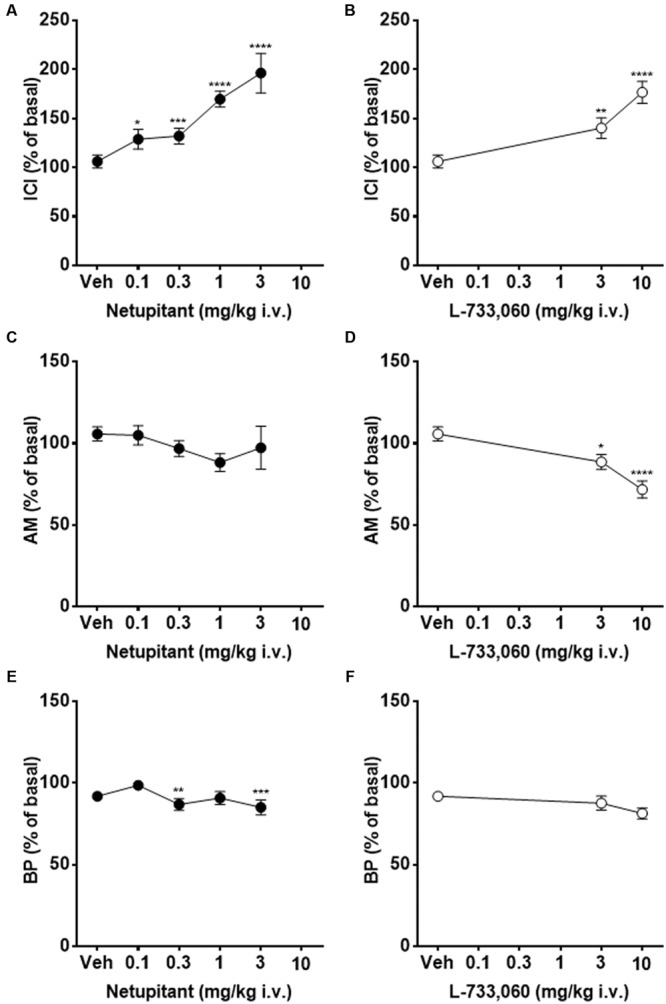
Continuous acetic acid infusion CMGs in female guinea-pigs. Graphs showing the effects of graded doses of netupitant on ICI (A), AM (C), and BP (E) (n = 10 for each), and those of L-733,060 on ICI (B), AM (D), and BP (F) (n = 10 for each). Asterisks indicate statistical difference from the basal (∗P < 0.05, ∗∗P < 0.01, ∗∗∗P < 0.001, ∗∗∗∗P < 0.0001, Sidak’s multiple comparison test following repeated measures two-way ANOVA). All statistical analyses were performed using actual values.